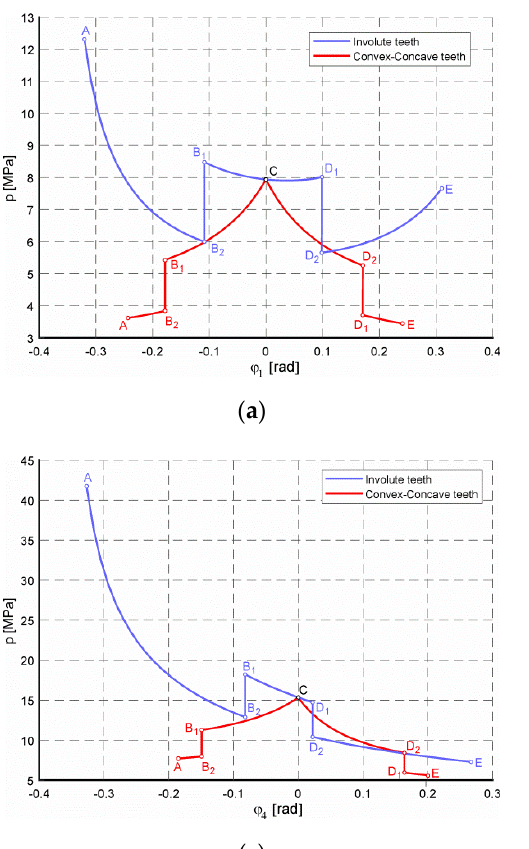
Table 3. Contact pressures of the partial gear pairs of the calculated gearbox.